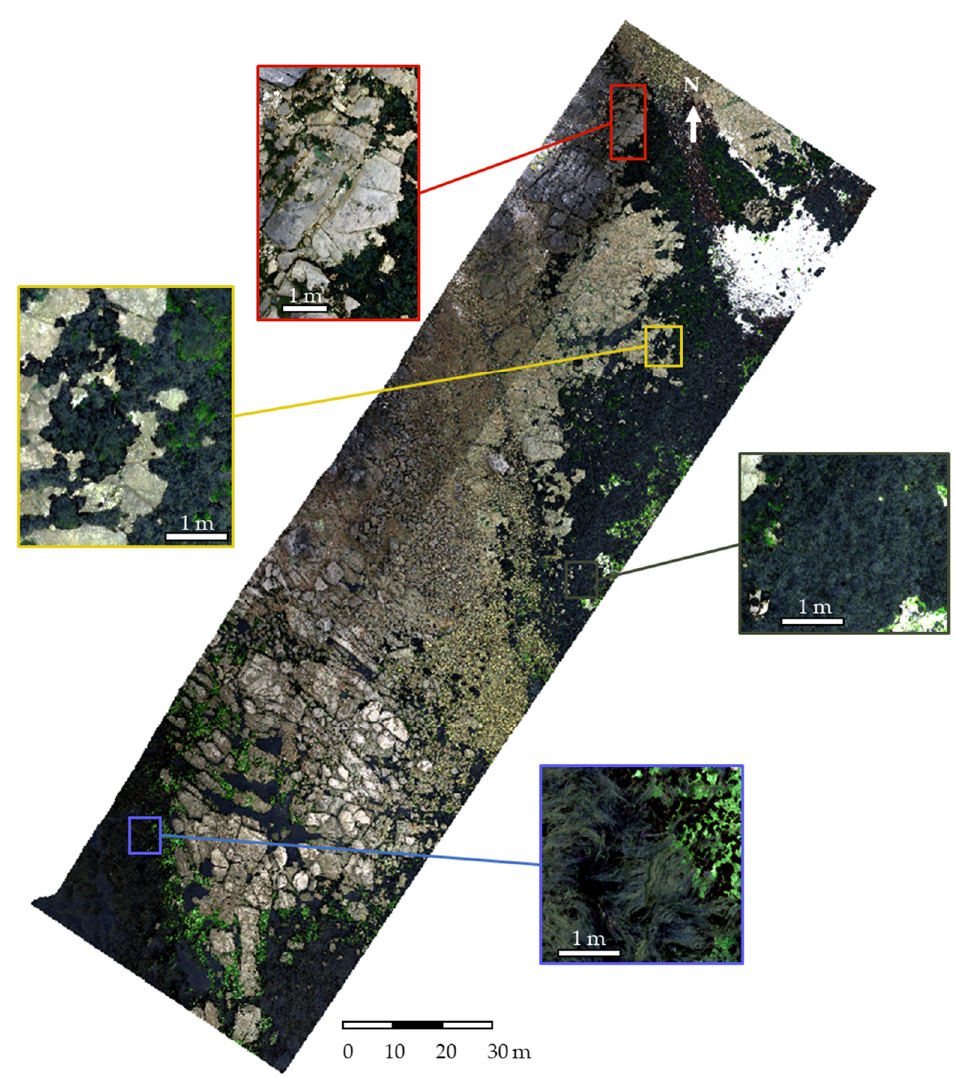
Figure 3. Porspoder orthophoto (RGB) obtained during the flight on the 24 June 2021. Detailed sections of the color image illustrating the different bathymetric levels on the shore are represented: Pc-Fspi (red square), An (yellow square), Fser (black square) and He-Ld (blue square).